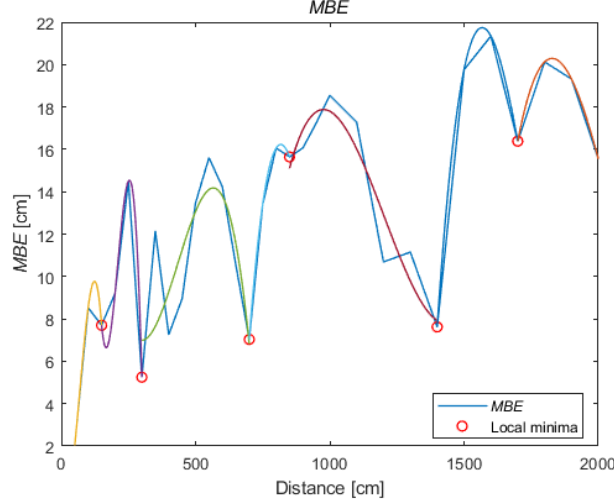
Figure 12. A polynomial approximation of the 𝑀𝐵𝐸 .